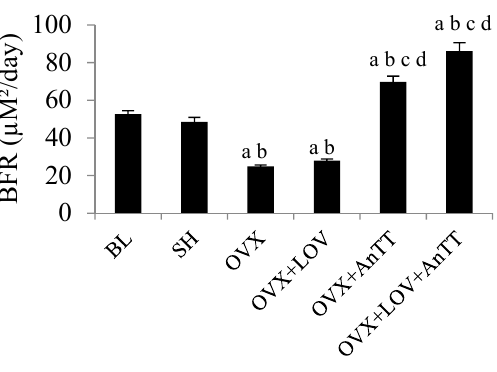
Figure 2. Bone dynamic histomorphometric parameters among the study group. Legend: Letters indicates significant difference between the marked group and ‘a’ BL; ‘b’ SH; ‘c’ OVX+LOV’; ‘d’ OVX+AnTT or ‘e’ OVX+LOV+AnTT. Abbreviation: BL = baseline; SH = sham-operated; OVX = ovariectomized; OVX+LOV = ovariectomized and supplemented with lovastatin (11 mg/day); OVX+AnTT = ovariectomized and supplemented with annatto tocotrienol (60 mg/kg/day); OVX+LOVAnTT = ovariectomized and supplemented with lovastatin (11 mg/day) and annatto tocotrienol (60 mg/kg/day).